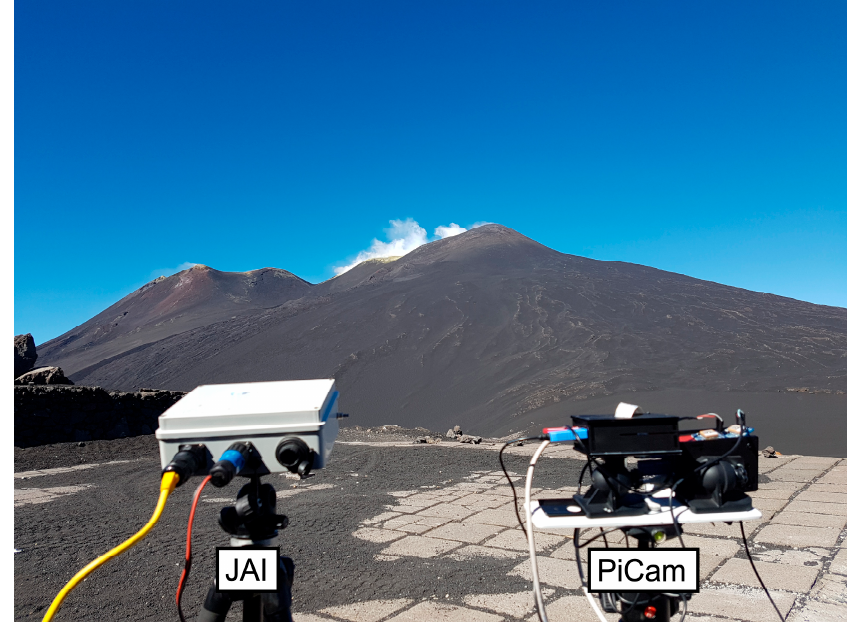
Figure 1. Side-by-side deployment of the JAI and PiCam UV cameras on 19 July 2016. The systems are imaging Etna’s North East Crater plume at ≈ 2.5 km distance.